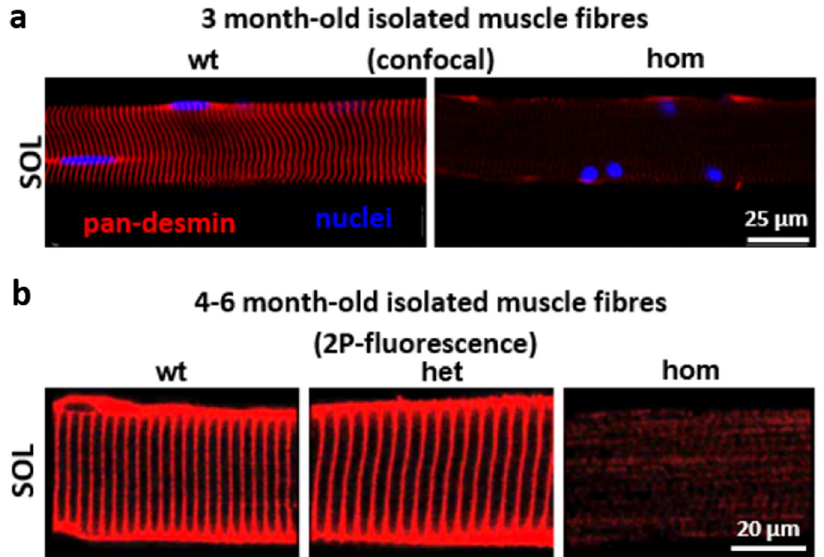
Figure 4. Desmin subcellular localization patterns in single fibers from soleus muscle of young Des R349P mice. ( a ) Confocal images taken from single SOL muscle fibers from 3-month-old wt and hom Des R349P mice. Note the vast reduction of regular cross-striated pattern and rounding of myonuclei in the hom fiber. ( b ) 2P-desmin- fluorescence in single muscle fibers from 5-month-old wt, het, and hom Des R349P mice. Note that these